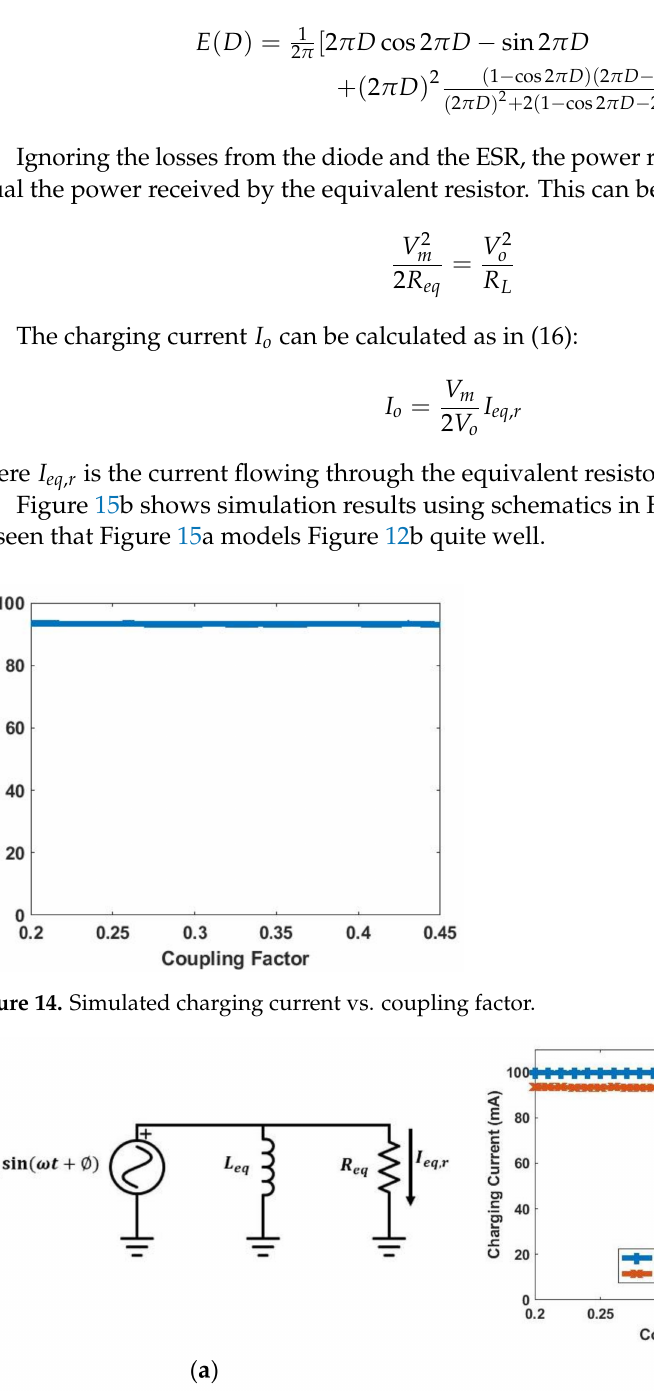
Figure 15. ( a ) Equivalent circuit model of Class-E rectifier; ( b ) simulation results using equivalent circuits in Figures 12b and